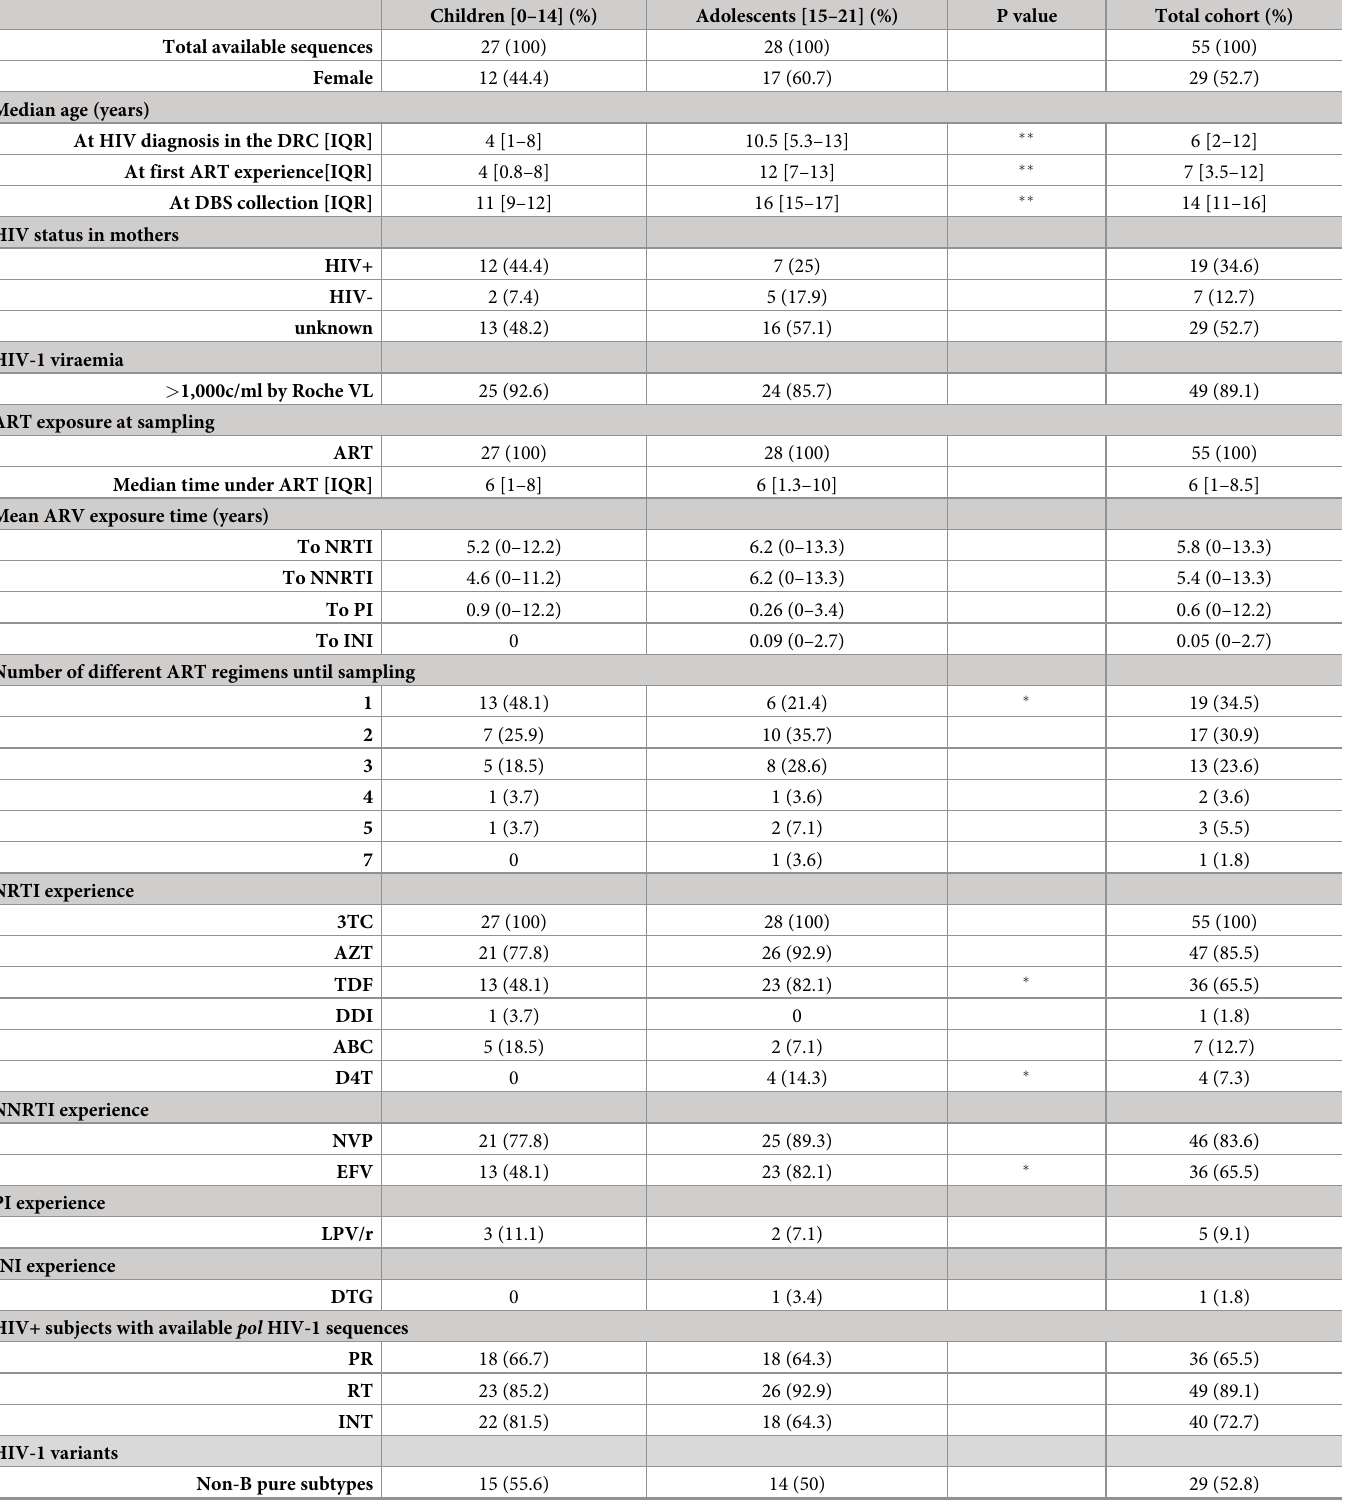
Table 1. Demographic and virological characteristics of children and adolescents of the study cohort with available HIV